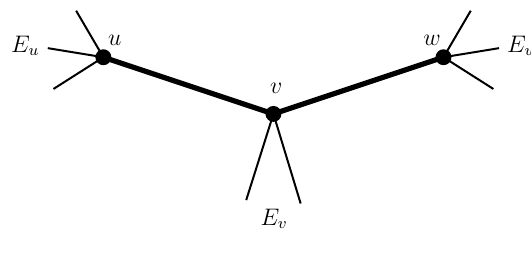
Fig. 4: The induced 2 -path uvw in